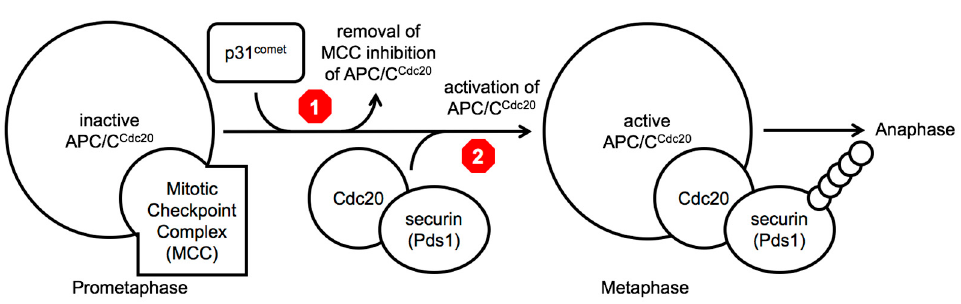
Figure 1. Sequential activation of APC/C Cdc20 from prometaphase to anaphase. During each cell cycle, and in the presence of anti-microtubule mitotic poisons, APC/C Cdc20 is inactive in prometaphase. Upon achievement of proper microtubule attachments to kinetochores, MCC inhibition of APC/C Cdc20 is removed concurrently with the activation of the APC/C Cdc20 enzyme to promote the poly-ubiquitinylation (small circles) of target substrates in metaphase that allows cell cycle progression into anaphase. In some cancer cells, even in the presence of a mitotic poison, the cells progress into anaphase and undergo ‘mitotic slippage’. To block these events, one potential target for inhibition is p31 comet (red stop sign 1) to block the removal of MCC inhibition and a second potential target is inhibiting the activation of APC/C Cdc20 towards substrates that promote entry into anaphase (red stop sign 2).